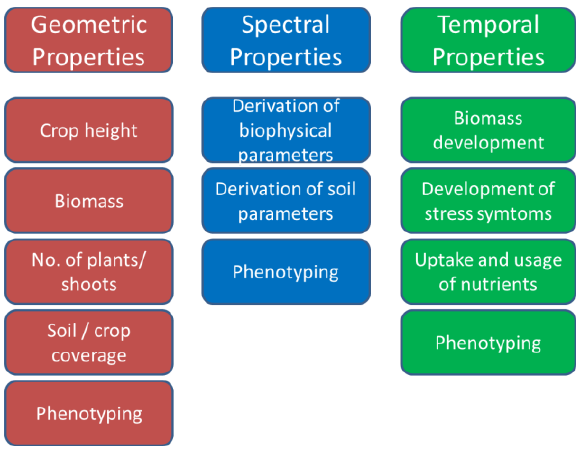
Figure 1: Overview of various information or plant properties for field trials, which can be derived from UAS